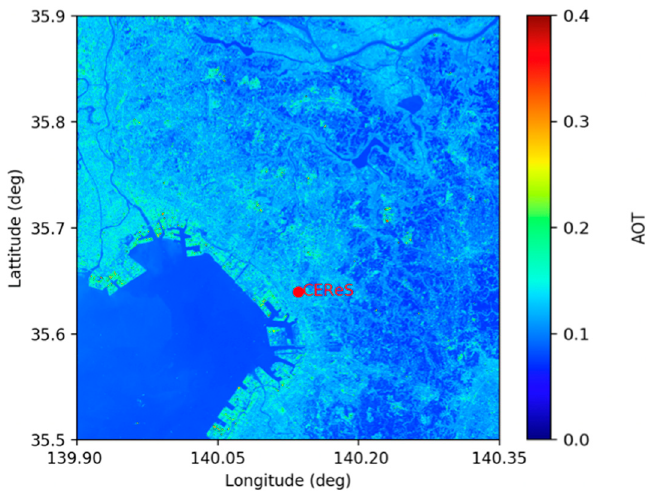
Figure 13. AOT distributions from Landsat-8 on 6 January 2020. The location of CEReS is indicated by the red dot, where the AOT values have been calculated.